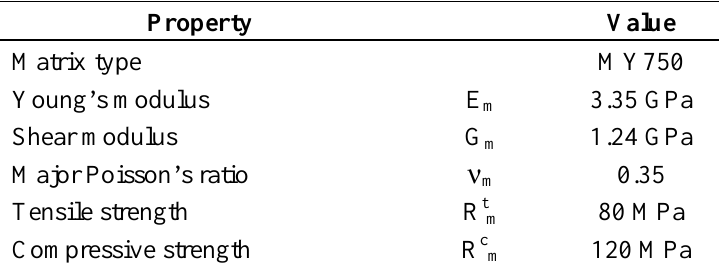
Table 4. Material properties used for the bonding